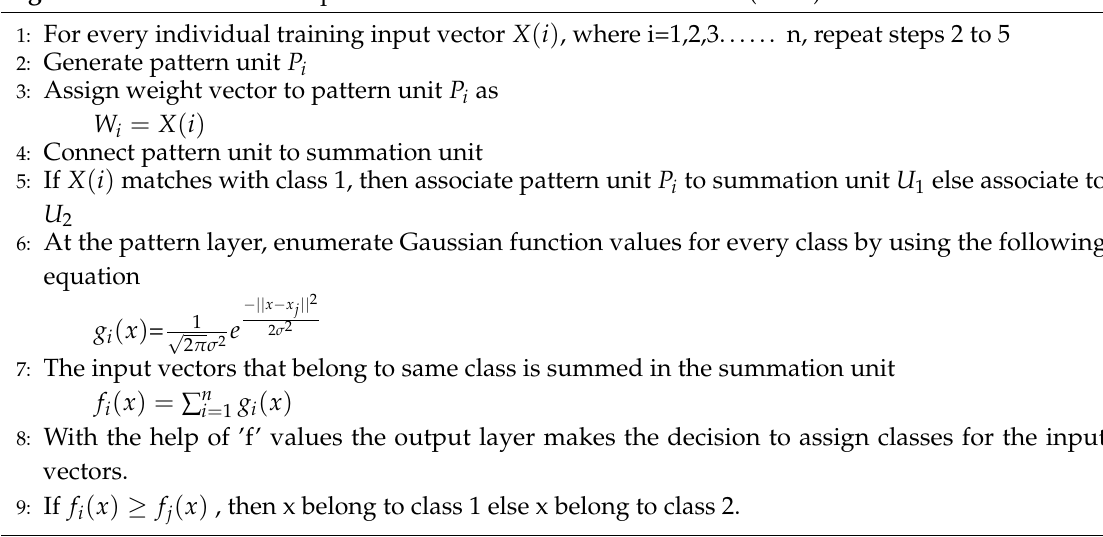
Algorithm 4 Procedure to implement Probabilistic Neural Network